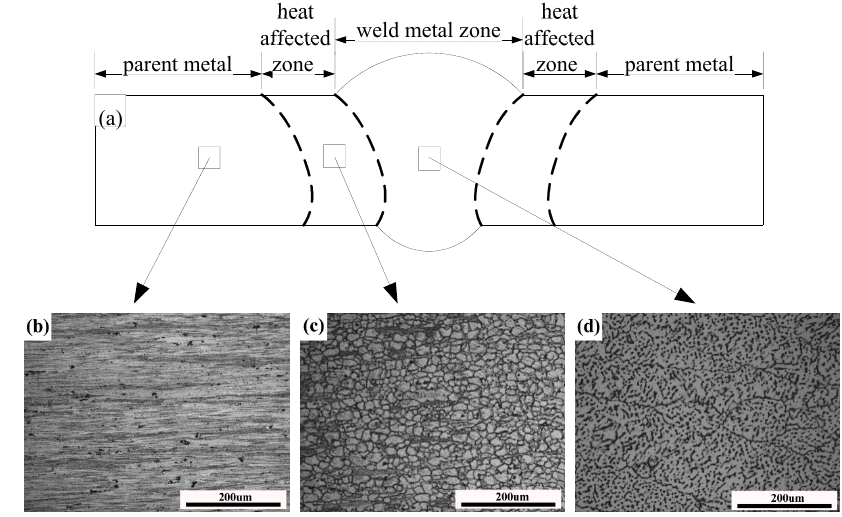
Figure 2. Optical microstructures of welded joint: ( a ) Schematic illustration of the welded joint; ( b ) parent metal; ( c ) heat affected zone; and ( d ) weld metal zone.